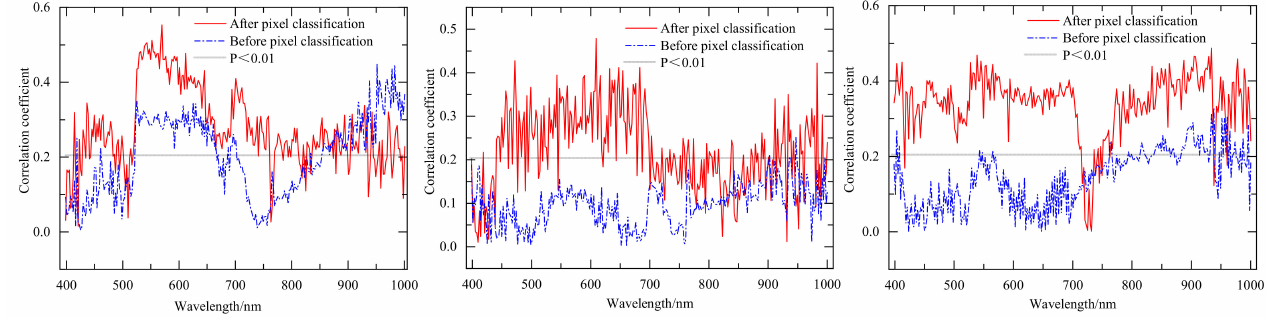
Figure 9. Correlation coefficient (absolute value) between SR and LNC in cotton before and after pixel classification.